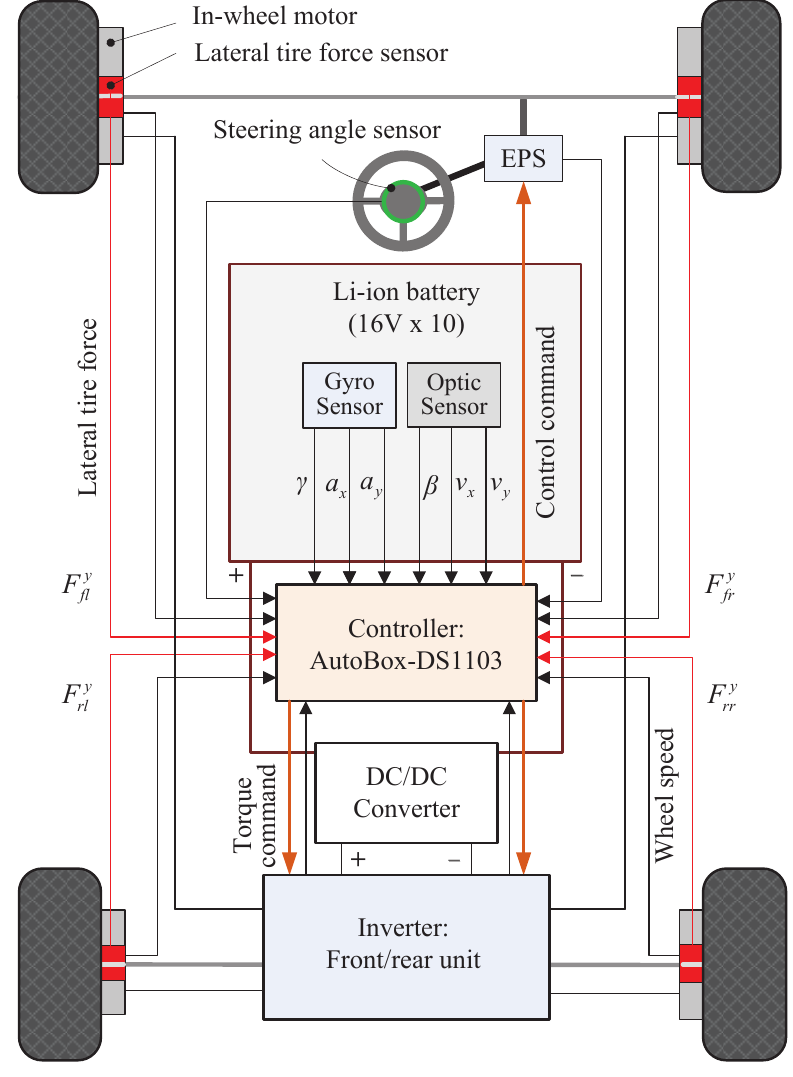
Figure 9. Description of the system interface of the experimental electric